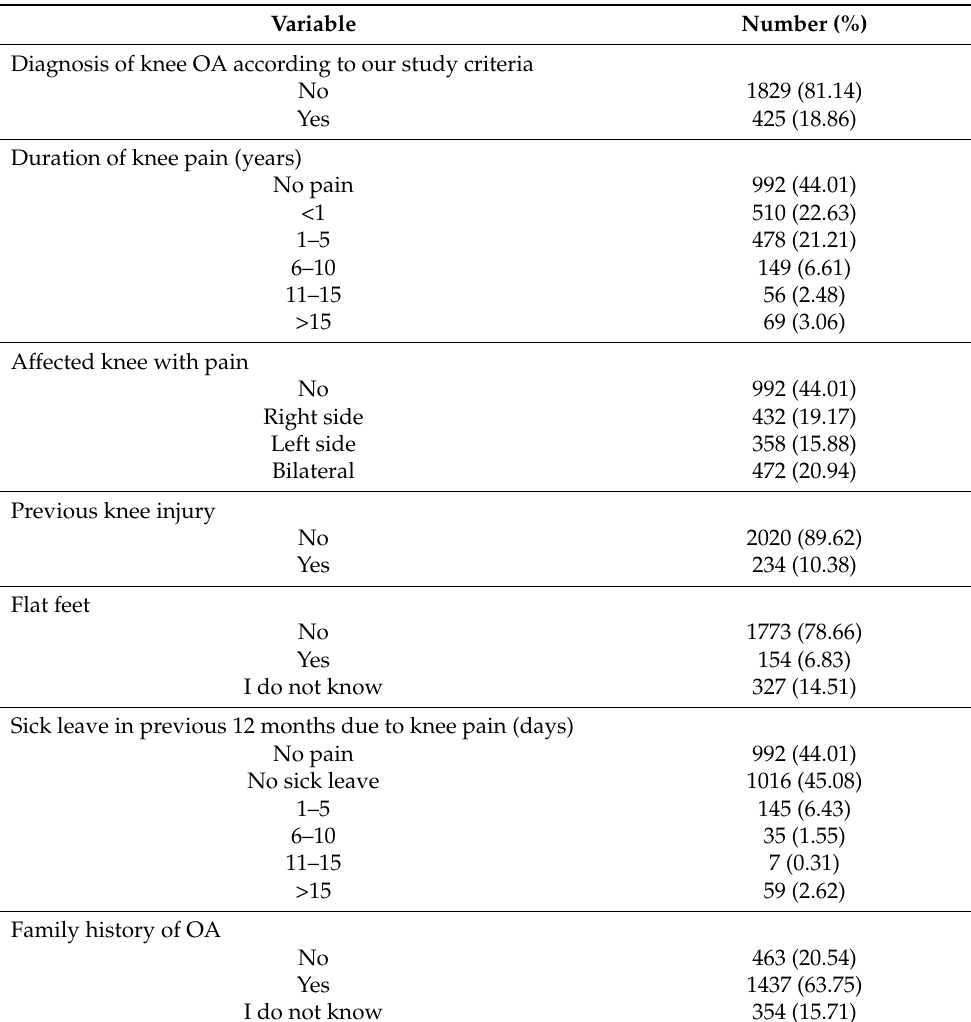
Table 2. Prevalence of OA and knee pain and associated risk